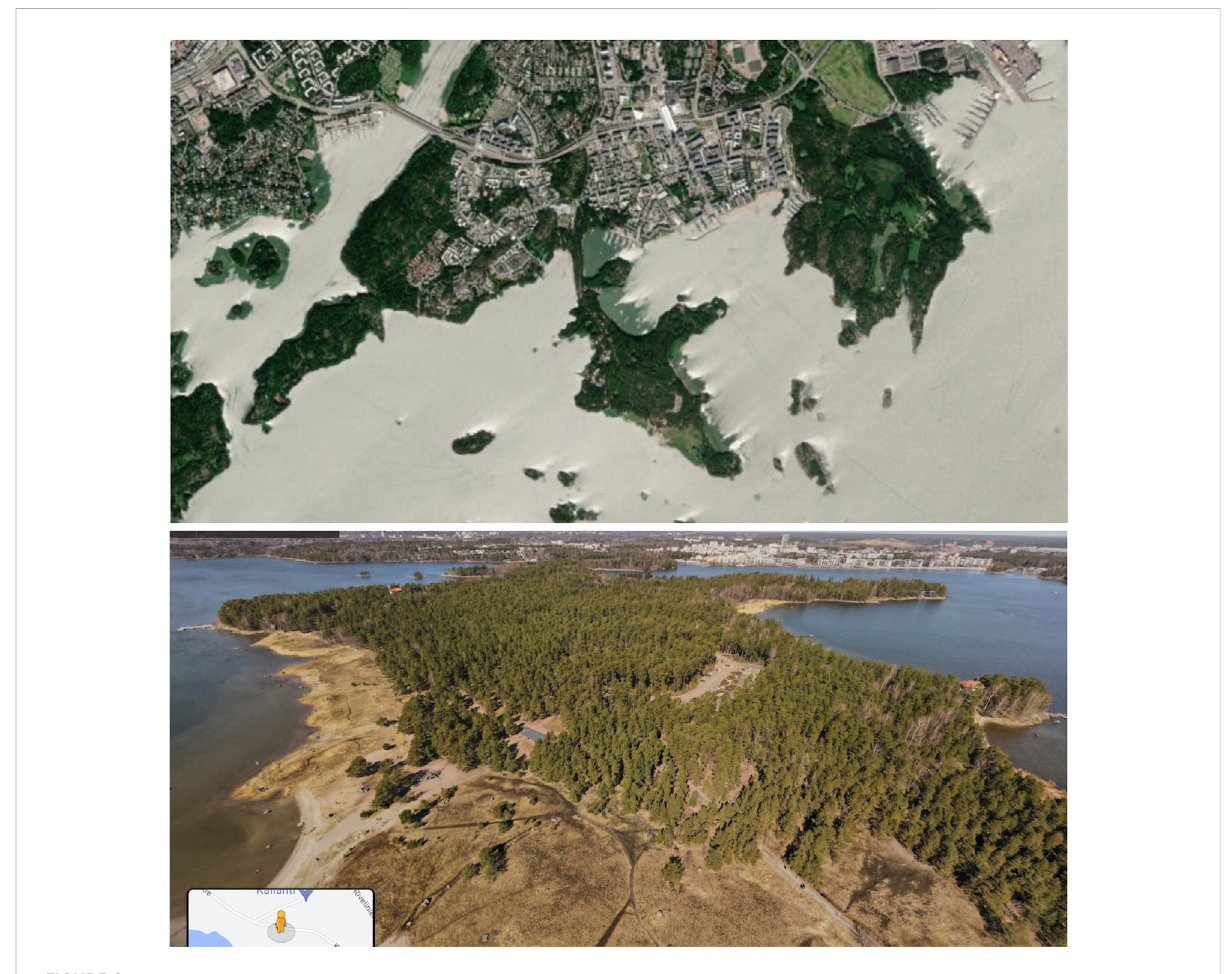
FIGURE 9 Psychological wellbeing urban greenspace characteristics. Ramsinranta Peninsula. Orthophoto Top — BingMaps (2022). Perspective photo bottom — GoogleEarth StreetView